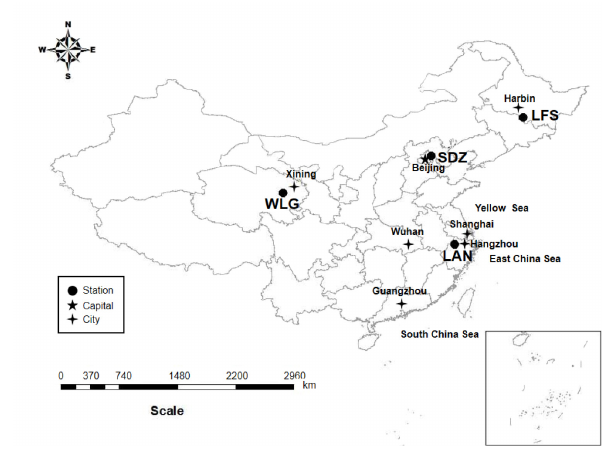
Fig. 1. Locations of the four Chinese WMO/GAW